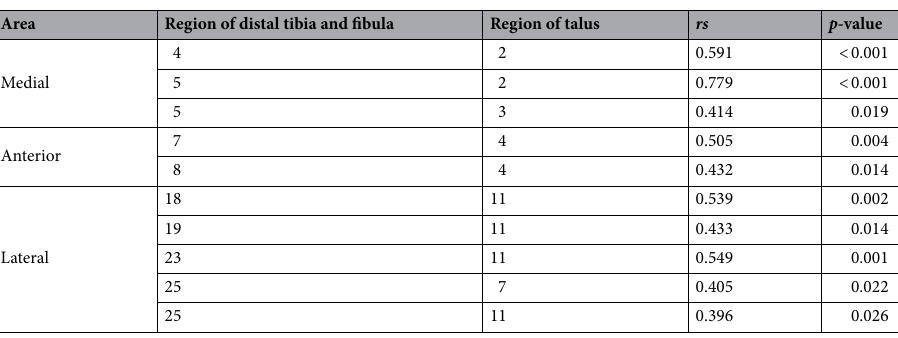
Table 2. Correlations of the left–right surface deviations between the distal tibia and fibula and the talus. Results were presented if the correlations were statistically significant ( p < 0.05). See Table 1 and Fig. 5 for the regions of the distal tibia and fibula. The regions of the talus were defined in our previous study 8 : region 2, the most superior point of the medial margin of the trochlea; region 3, the most posterior point of the medial margin of the trochlea; region 4, the midpoint of the anterior margin of the trochlea; region 7, the most anterior point on the lateral margin of the trochlea; region 11, the most inferior point of the lateral articular facet. rs , Spearman’s rank correlation